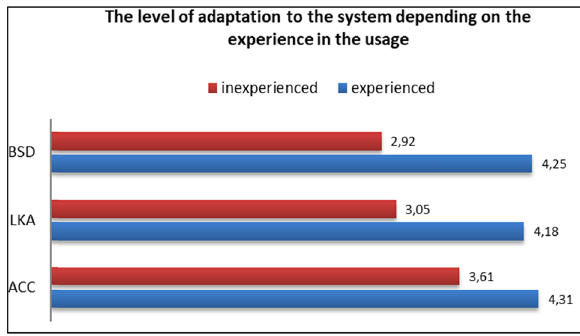
Figure 7: The experience of drivers and the level of adaptation to the use of systems. Source: author ’ s own